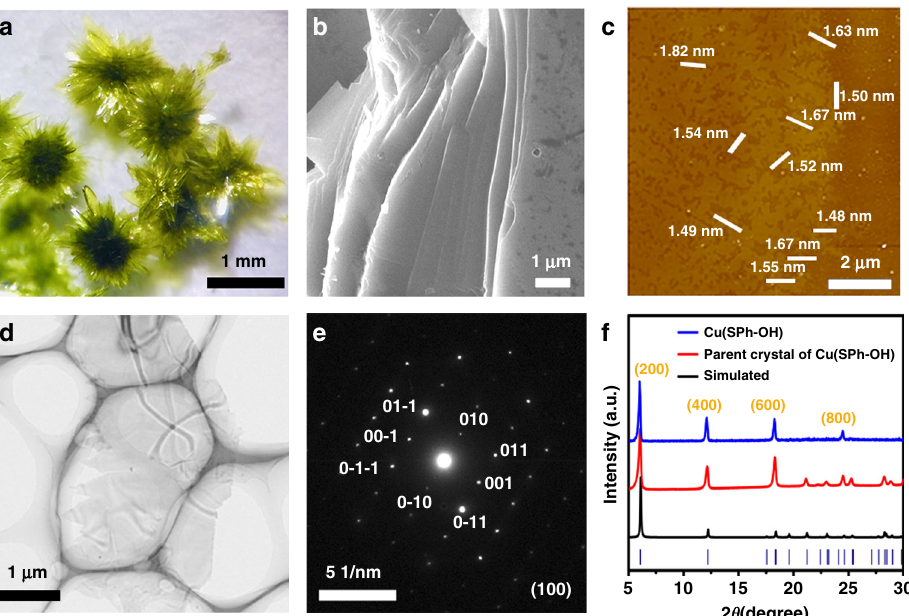
Fig. 2 Synthesis and characterization of OMCs. a Optical photograph and b SEM of the parent bulk MOF of Cu(SPh-OH) ; c AFM image of monolayer Cu (SPh-OH) ; d TEM of Cu(SPh-OH) and e , its corresponding SAED pattern; f PXRD pattern of Cu(SPh-OH) and its parent bulk MOF